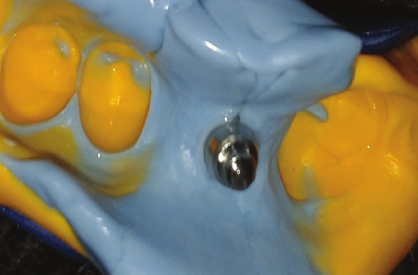
Figure 14: Window prepared in the tray.